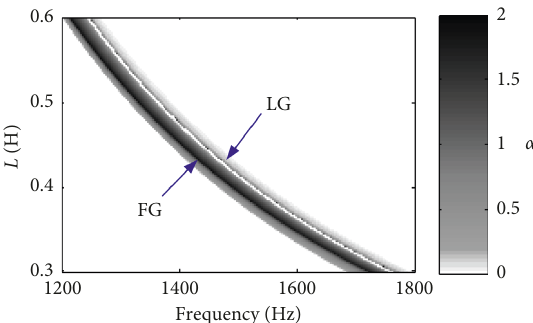
Figure 7: Variation of band gaps with shunting